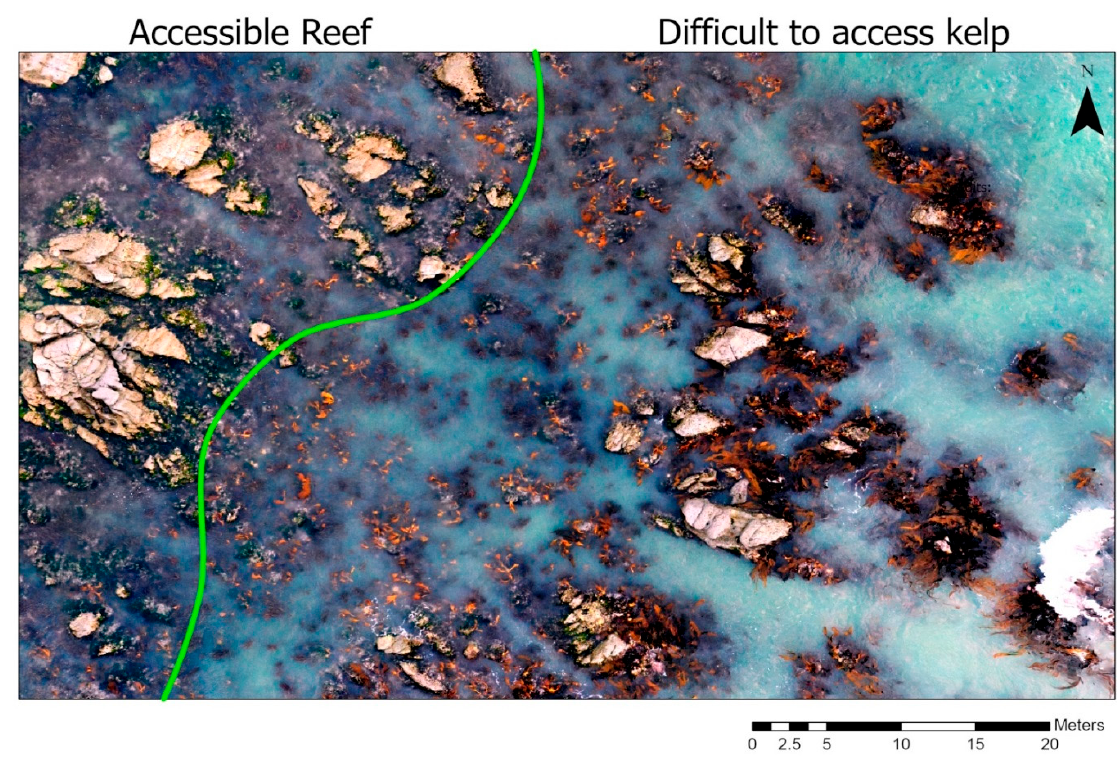
Figure 4. This shows an example of how aerial drones improve access to information about key marine ecosystem engineers. Southern bull kelp ( Durvillaea species) were greatly affected by earthquake uplift, marine and air heatwaves, and coastal sedimentation, but accessing these habitats is challenging. The rocky reef habitats accessible from land (left of green line) contains few examples of Durvillaea at this site, yet aerial images show a high abundance attached to offshore rocks (accessible to neither shore-based nor boat-based operations). This image is from the Cape Campbell site.